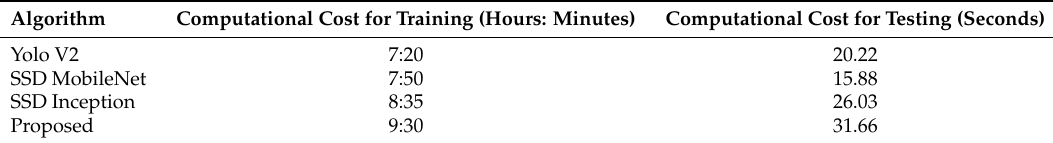
Table 5. Computational cost analysis.